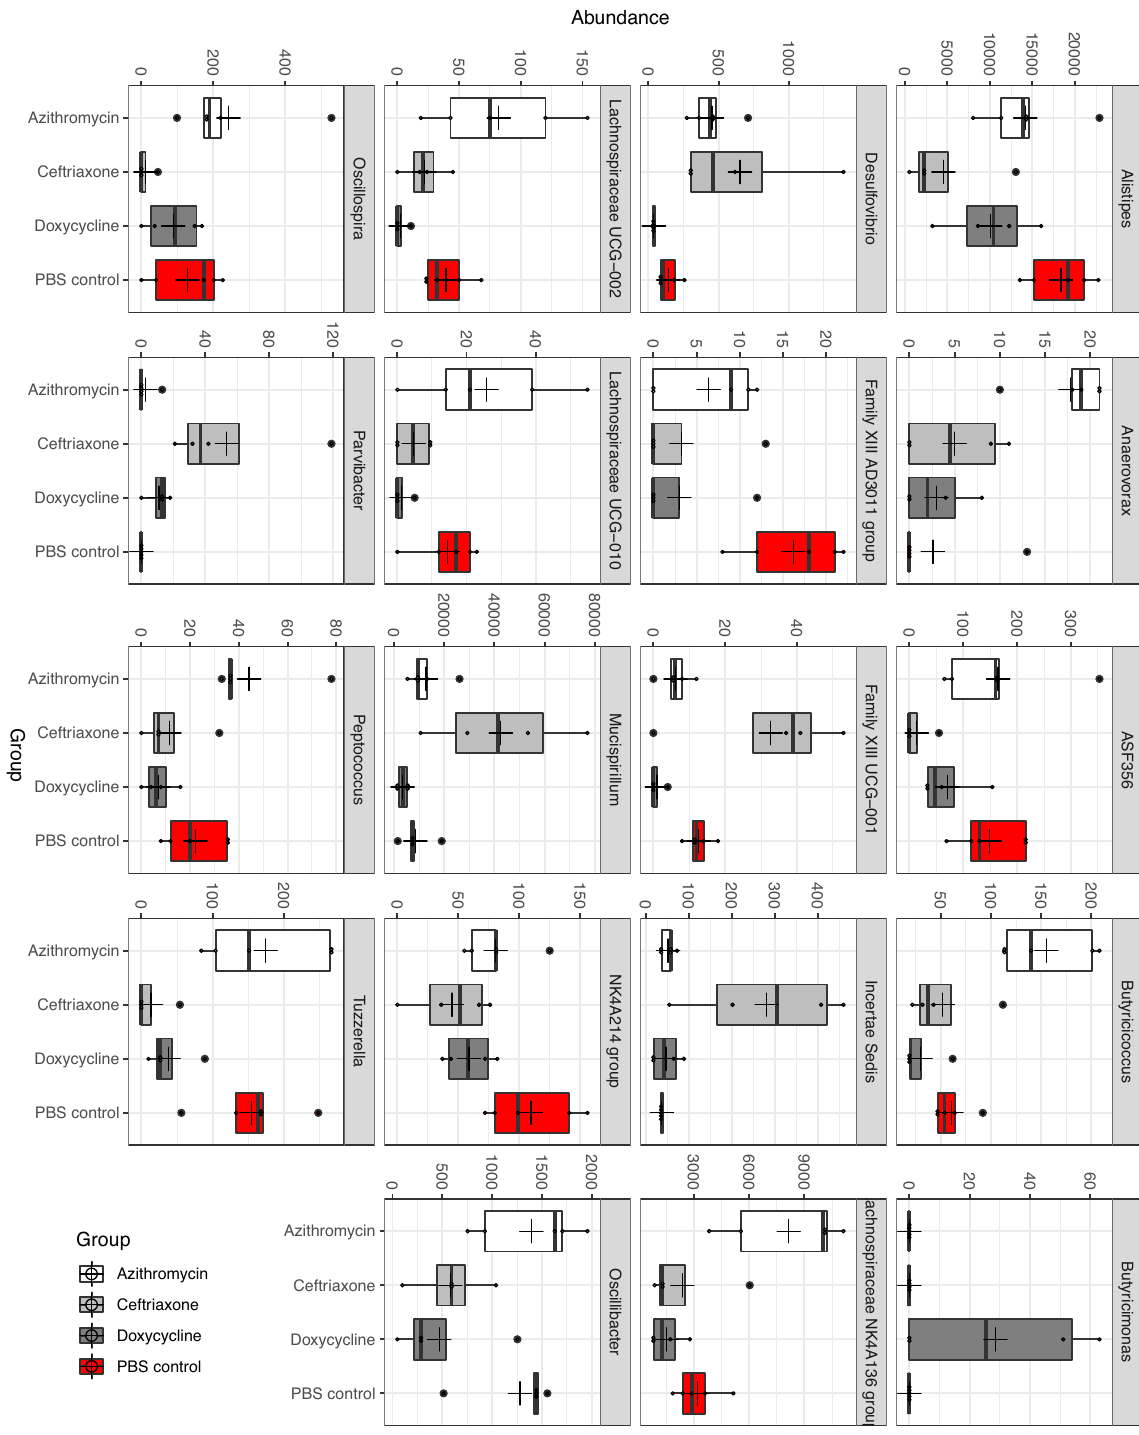
Figure 3 . Differential abundance analysis ( P <0.05, ANOVA, Benjamini-Hochberg (BH)) highlighting 19 taxa at genus level whose abundance was differentially altered in the antibiotic treatment groups versus the phosphate-buffered saline (PBS) control